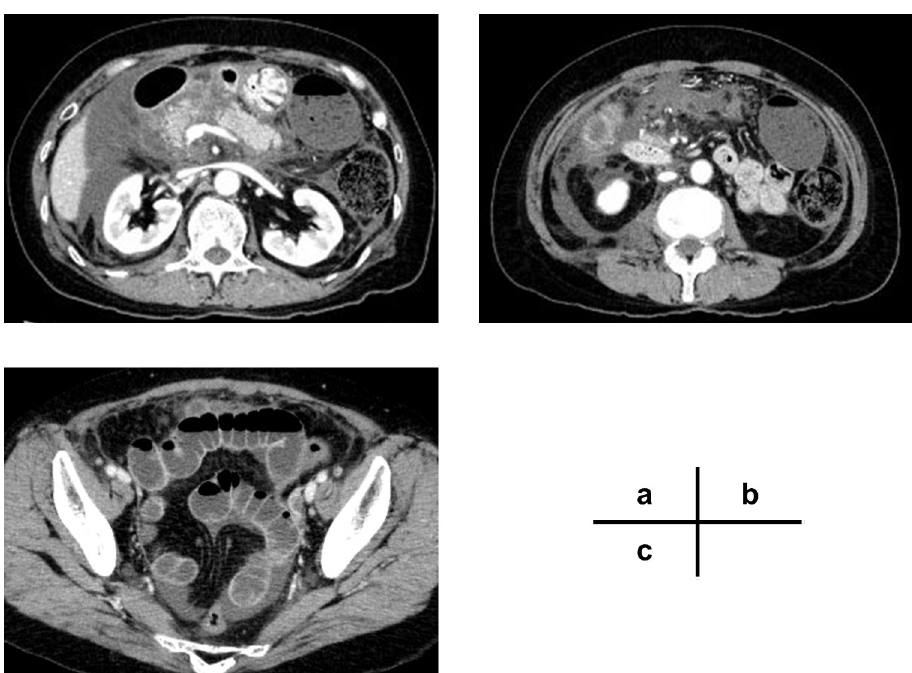
Fig 2. Radiologic findings of inflammation extending to the rectovesical excavation. (a) Hypo-enhanced lesion in the body of the pancreas and an ill-defined, single peripancreatic fluid collection (Balthazar score [9] D). (b) Inflammation extending over the inferior pole of the kidney. (c) Inflammation extending to the rectovesical excavation.